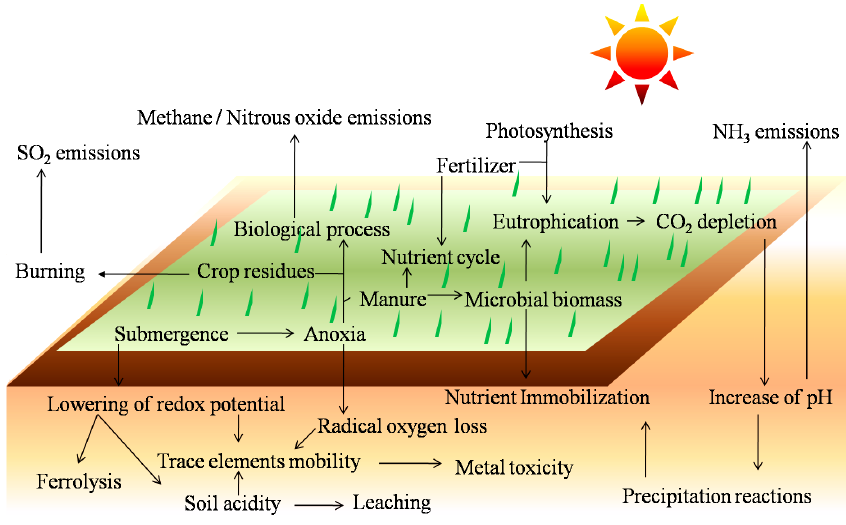
Figure 2. Nutrient cycling and mobilization of TEs in rice